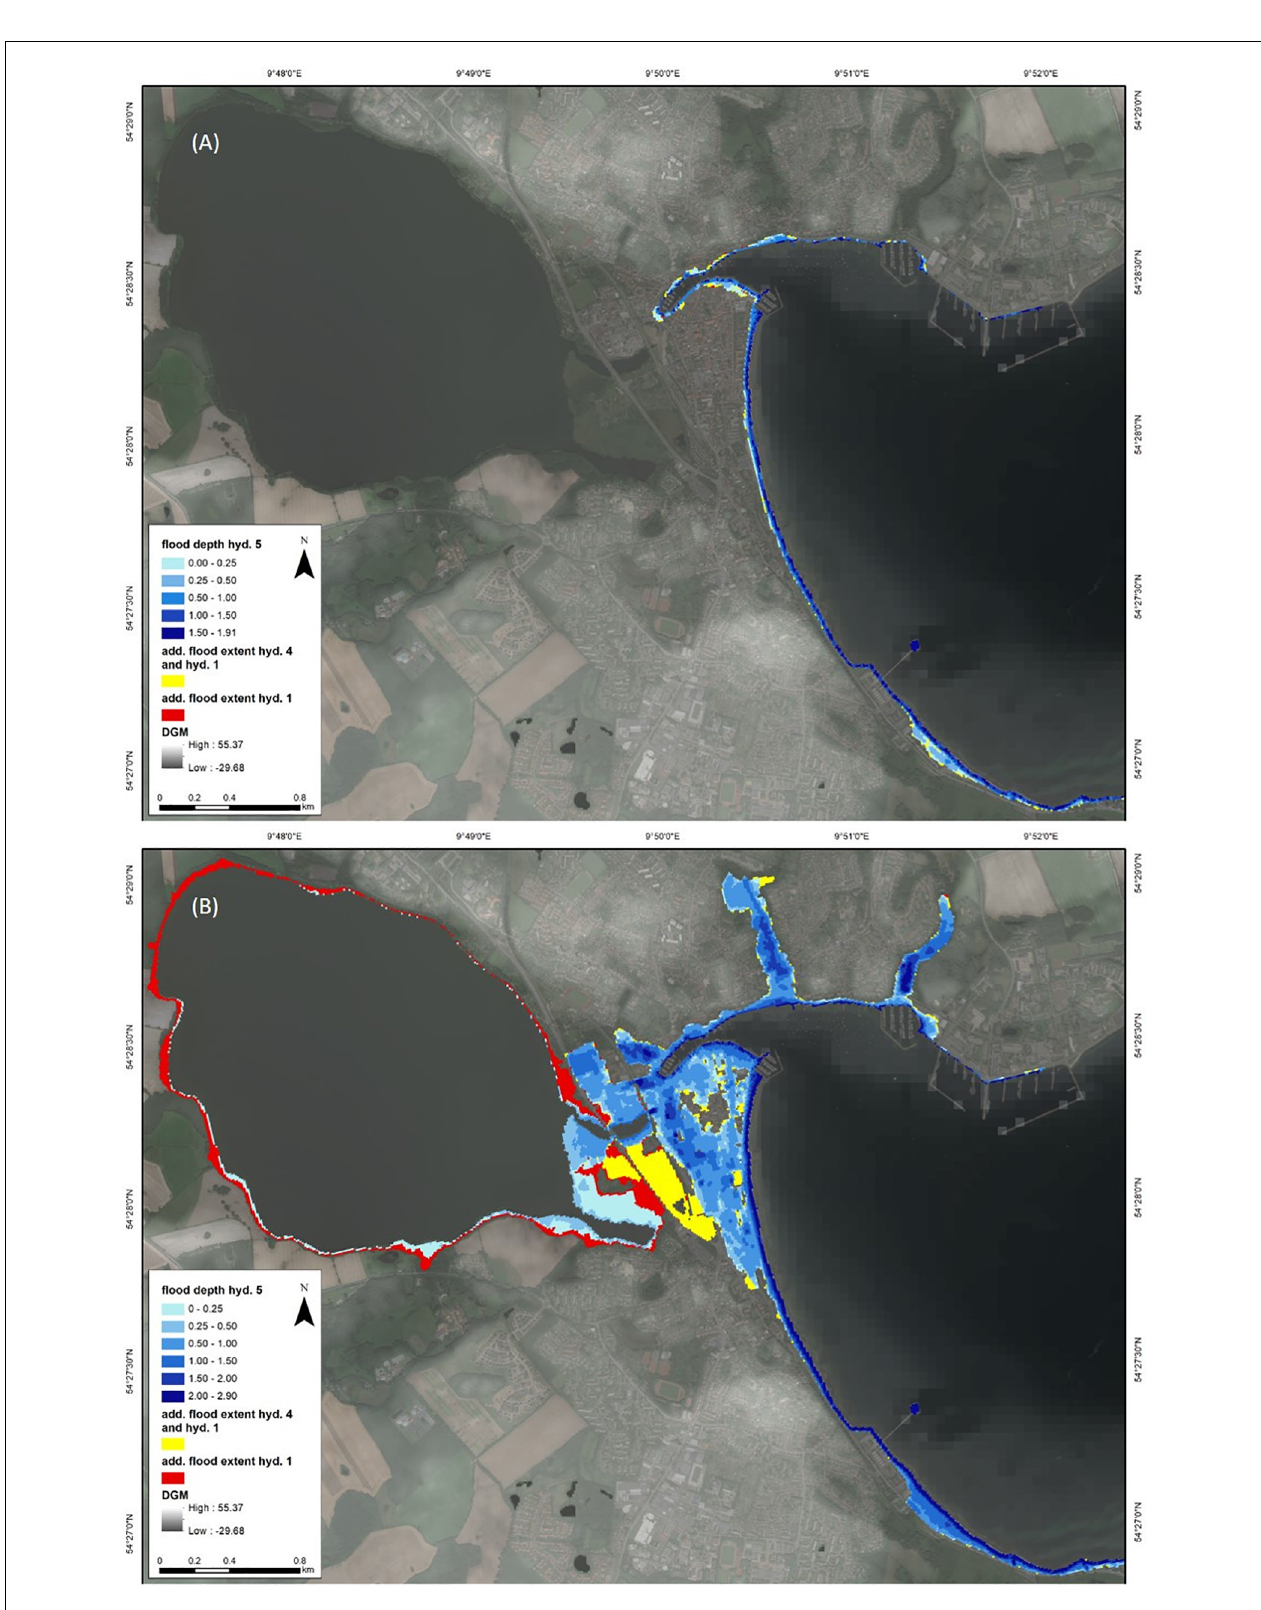
FIGURE 7 | Flood extent simulated with Delft3D for hydrographs with water levels corresponding to a 200-year return period (A) and in combination with 1 m sea-level rise (B) . The areas visualized in blue represent the flood extent of H5. The yellow colored pixels indicate the additional extent flooded in the simulation of H4 and H1. The red pixels display the extent only flooded in the case of